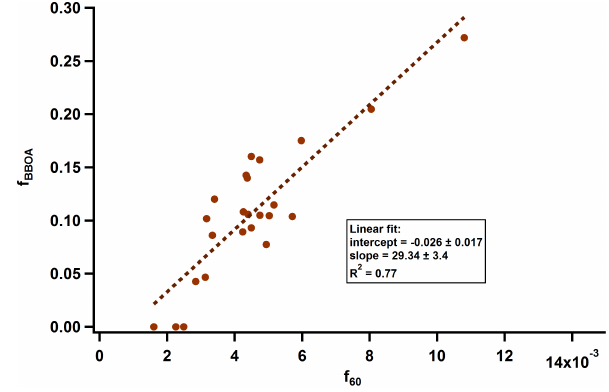
Figure 8. Average BBOA fractional contribution vs. average f 60 for each